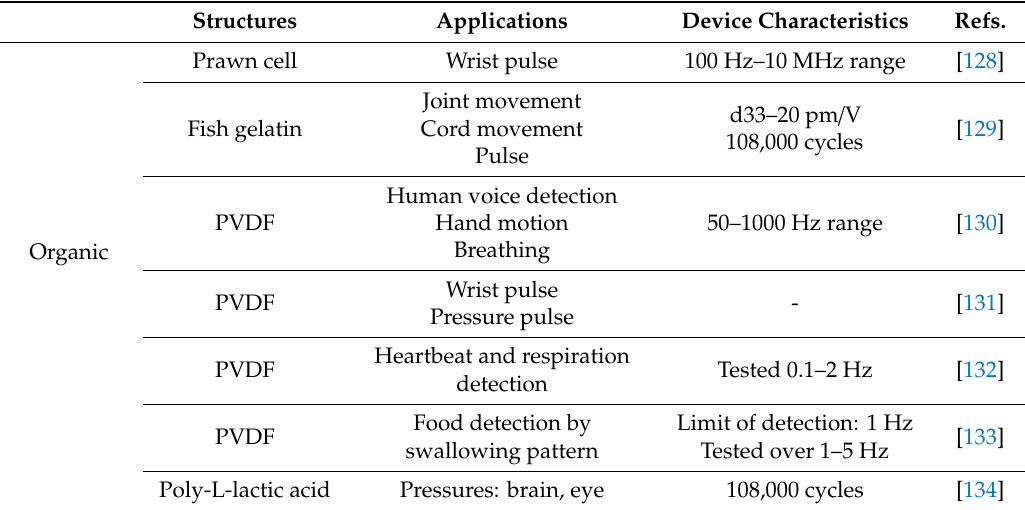
Table 5. Comparison of organic piezoelectric sensors for di ff erent medical applications.